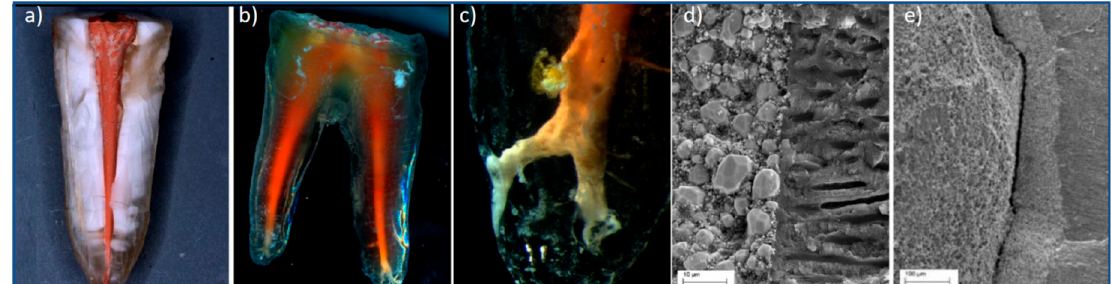
Figure 33. Examples of endodontically treated tooth with root canal filled with gutta-percha material with AH Plus sealant by the thermoplastic method: ( a ) longitudinal fracture of the tooth; ( b , c ) decalcified teeth; ( c ) root delta of the transverse fracture of the canal dentin; ( d ) in all sections of the root canal the material based on gutta-percha and sealant is tightly connected; ( e ) the border of three layers: a sealant layer covering the material on the gutta-percha matrix in a leak between a thick intermediate layer of sealant and the sealant with tightly connected dentine of the root canal after an incorrectly performed procedure; ( c ) atomic force microscope; ( d , e )—scanning electron microscope.